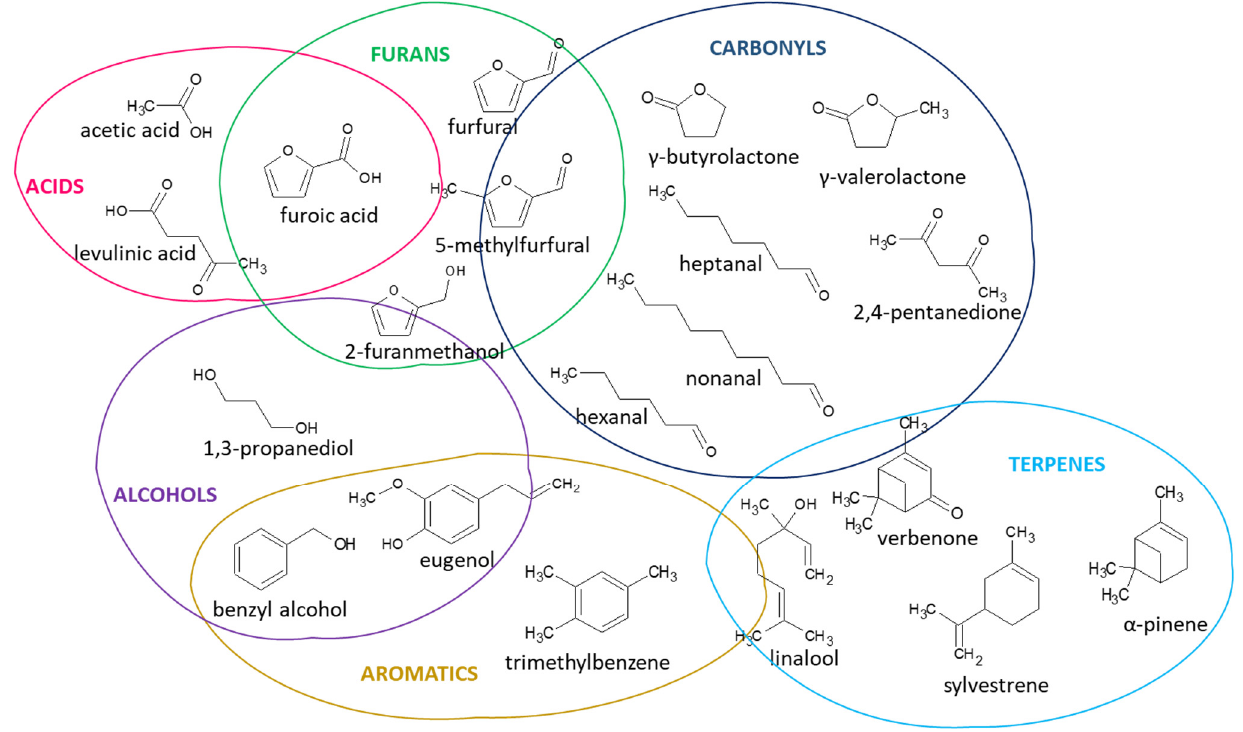
Figure 3. Examples of different chemical species detected in VOCs emitted from the bio-based particleboards.